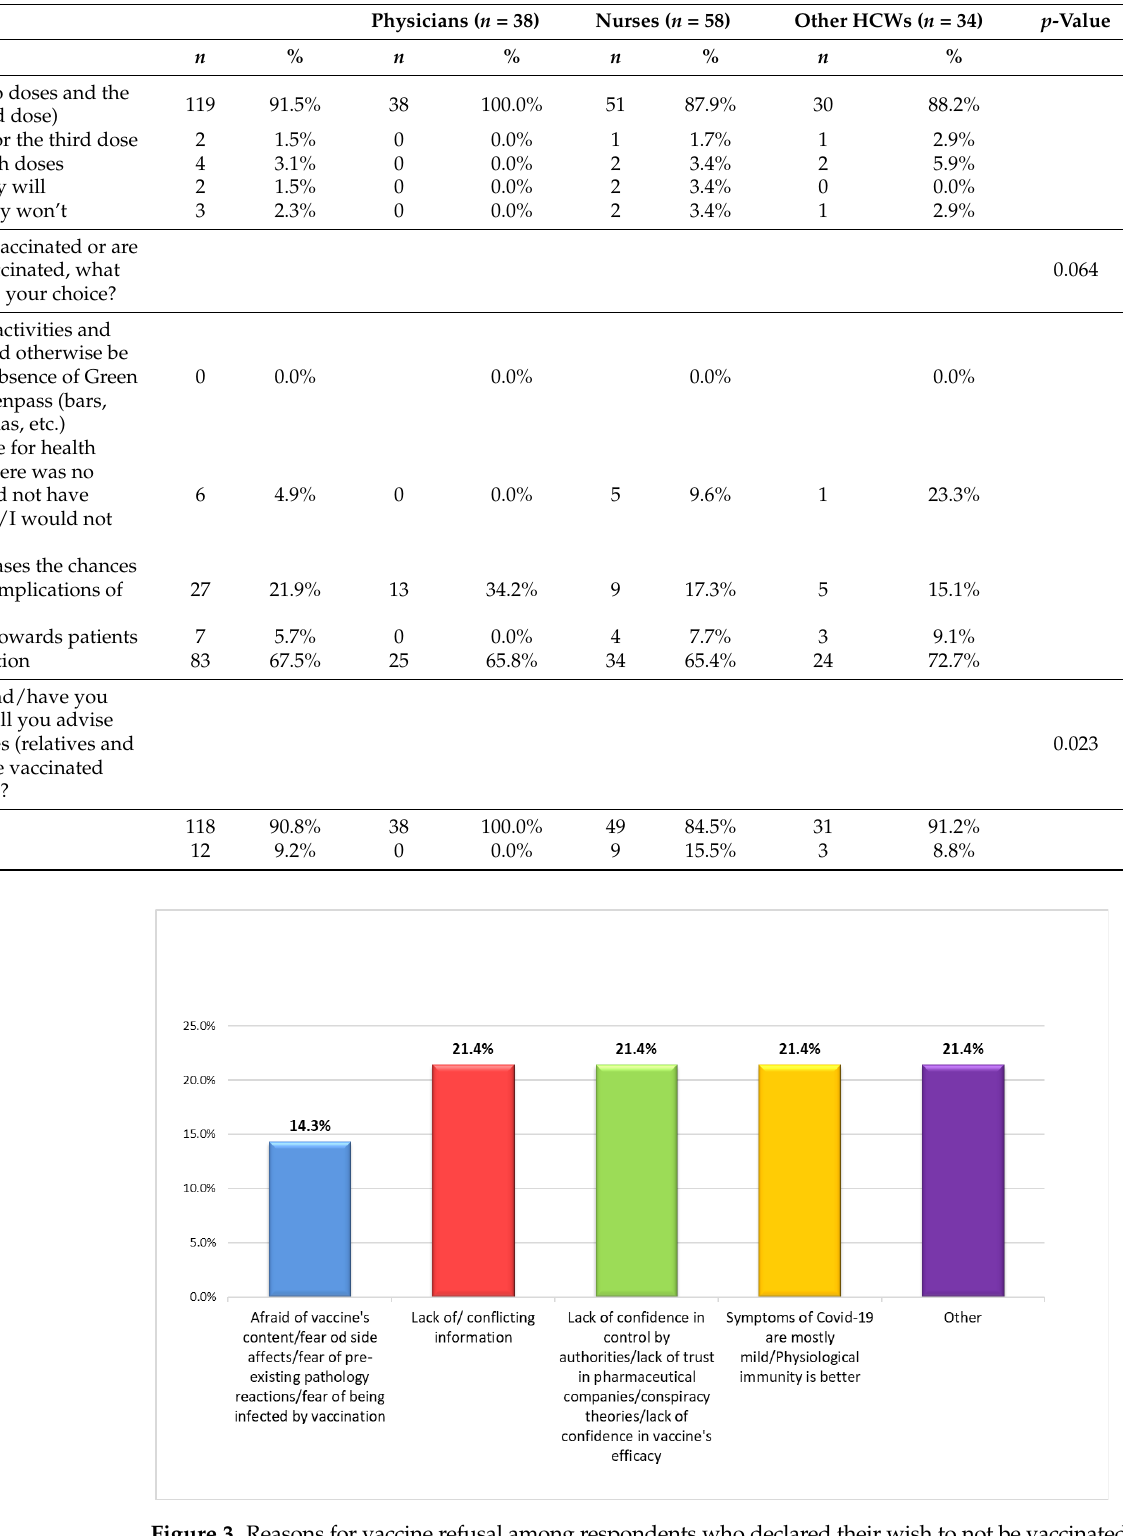
Figure 3. Reasons for vaccine refusal among respondents who declared their wish to not be vac- cinated.